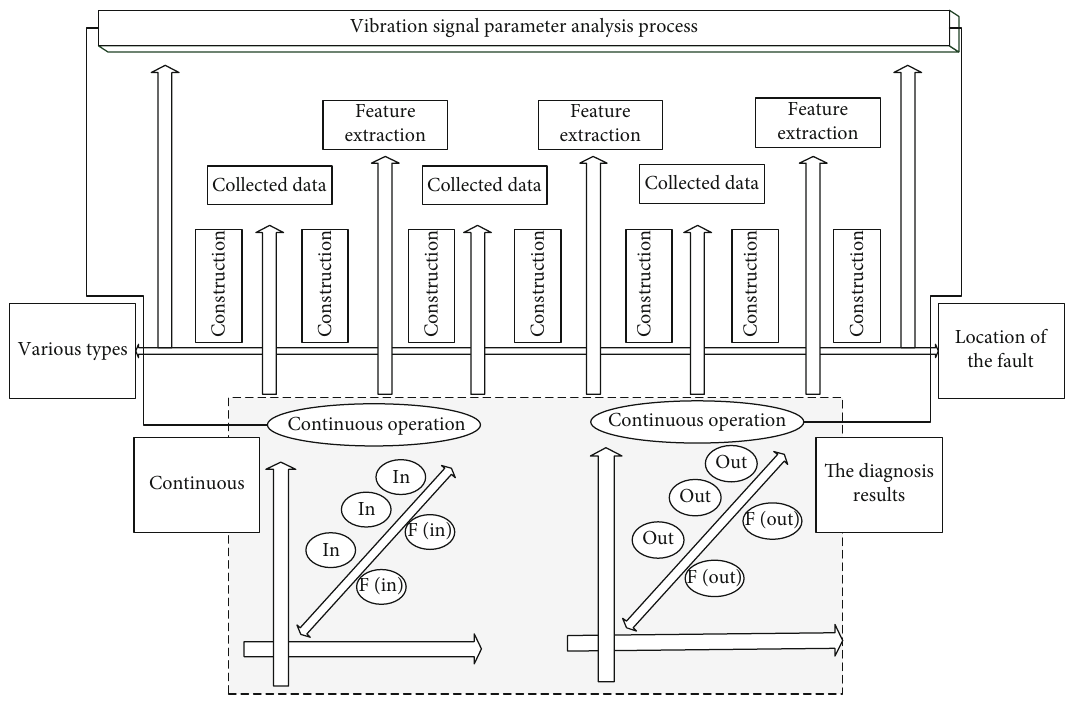
Figure 1: Vibration signal parameter analysis